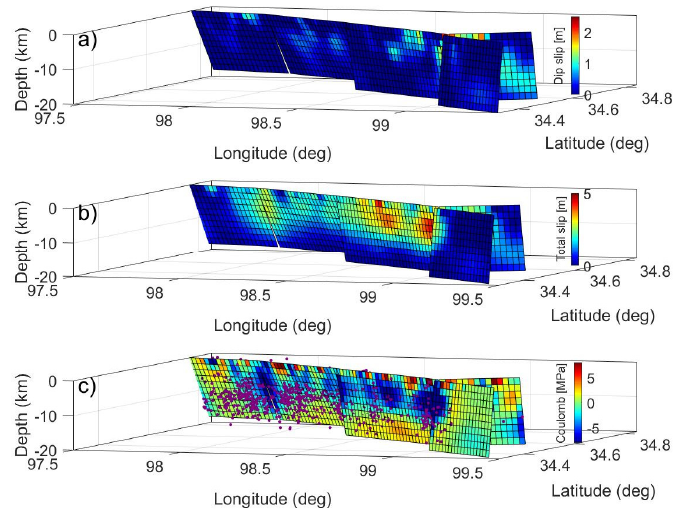
Figure 5. Coseismic slip distribution of the Maduo earthquake. ( a ) Estimated coseismic slip along the dip direction; ( b ) Estimated coseismic slip along the fault strike; ( c ) Coulomb stress change on the fault plane. The purple dots indicate the relocated aftershocks [20].